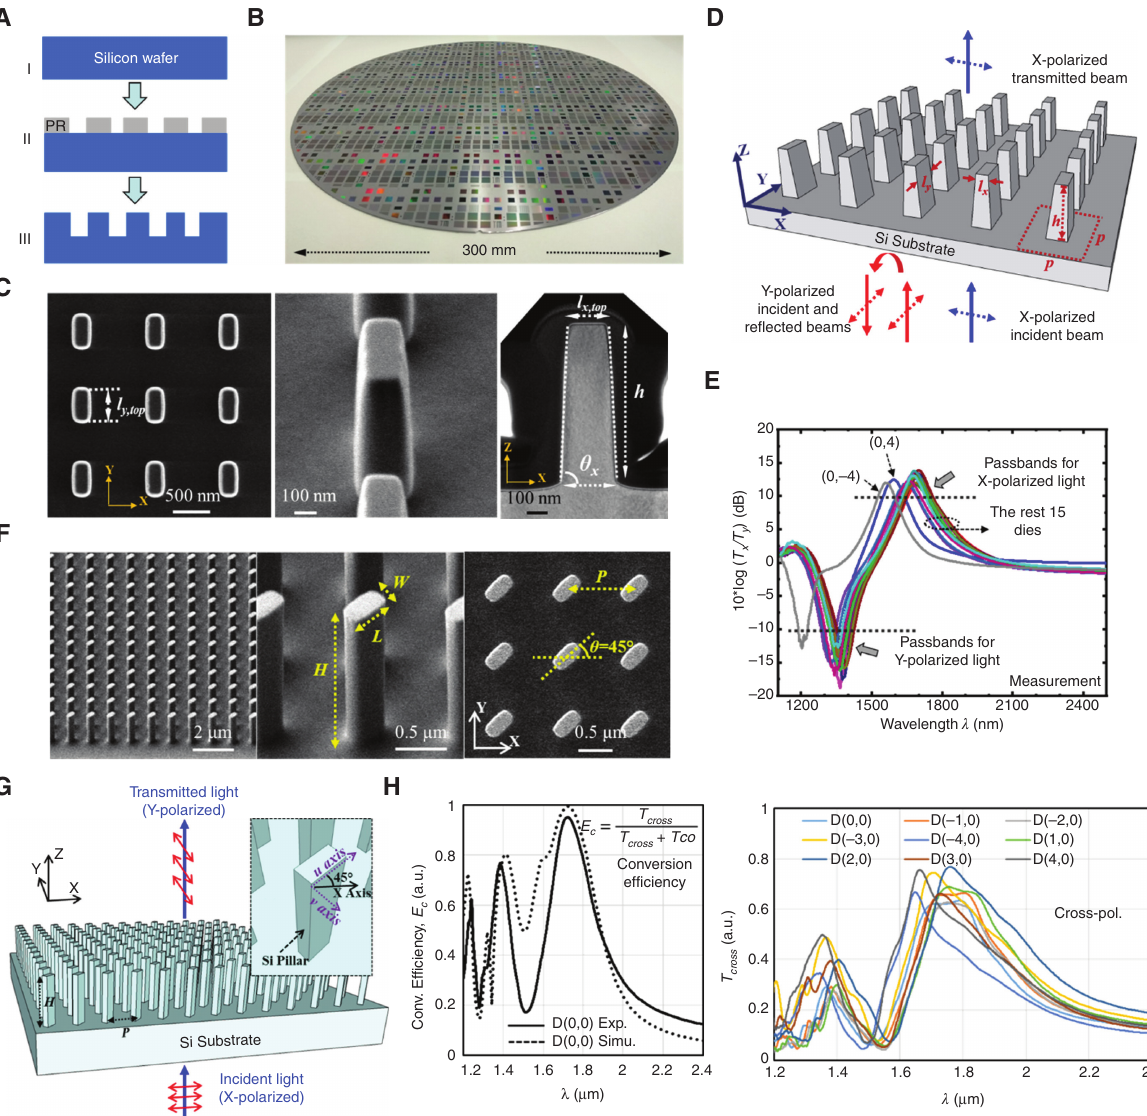
Figure 4: Metasurface-based devices demonstrated using immersion scanner and direct etching on 12-inch Si wafer. (A) Fabrication process flow. (B) Fabricated 12-inch Si wafer. Adapted with permission from [69]. (C) SEM images of the pyramid nanopillar for PBF showing the top and 45 ° tilted views, respectively, and TEM image of the pyramid nanopillar showing the cross-sectional view. (D) Schematic of the PBF. (E) Measurement results of PBF selected across the wafer, showing 15 of 17 dies having 10 dB power distinction at designed wavelength. (C–E) Adapted with permission from [63]. © The Optical Society. (F) SEM images of the rectangular nanopillar for HWP, showing the 45 ° tilted view of pillar array, single pillar, and the top view of the pillar array, respectively. (G) Schematic of HWP. (H) Experimental and simulation results of HWP, showing polarization conversion efficiency ( E T . (F–H) Adapted with permission from cross